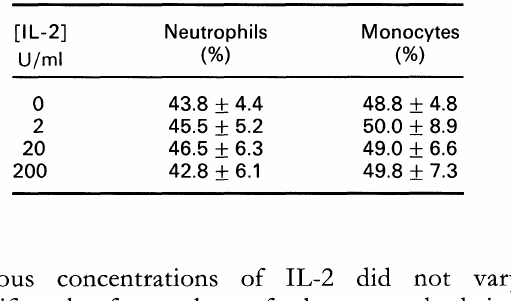
Table 1. Concentrations of L-2 between 2 and 200 U/ml had no effect on neutrophil or monocyte phagocytosis